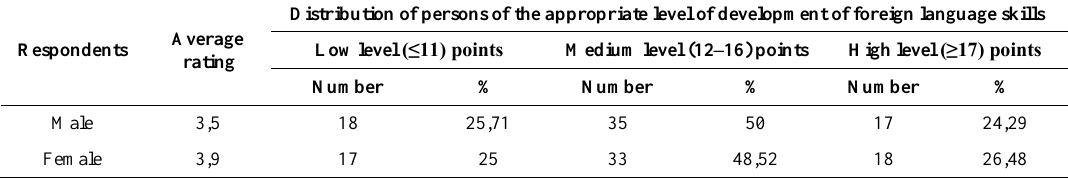
Table 1. Level of foreign language skills at ascertaining stage of the experiment (gender aspect)